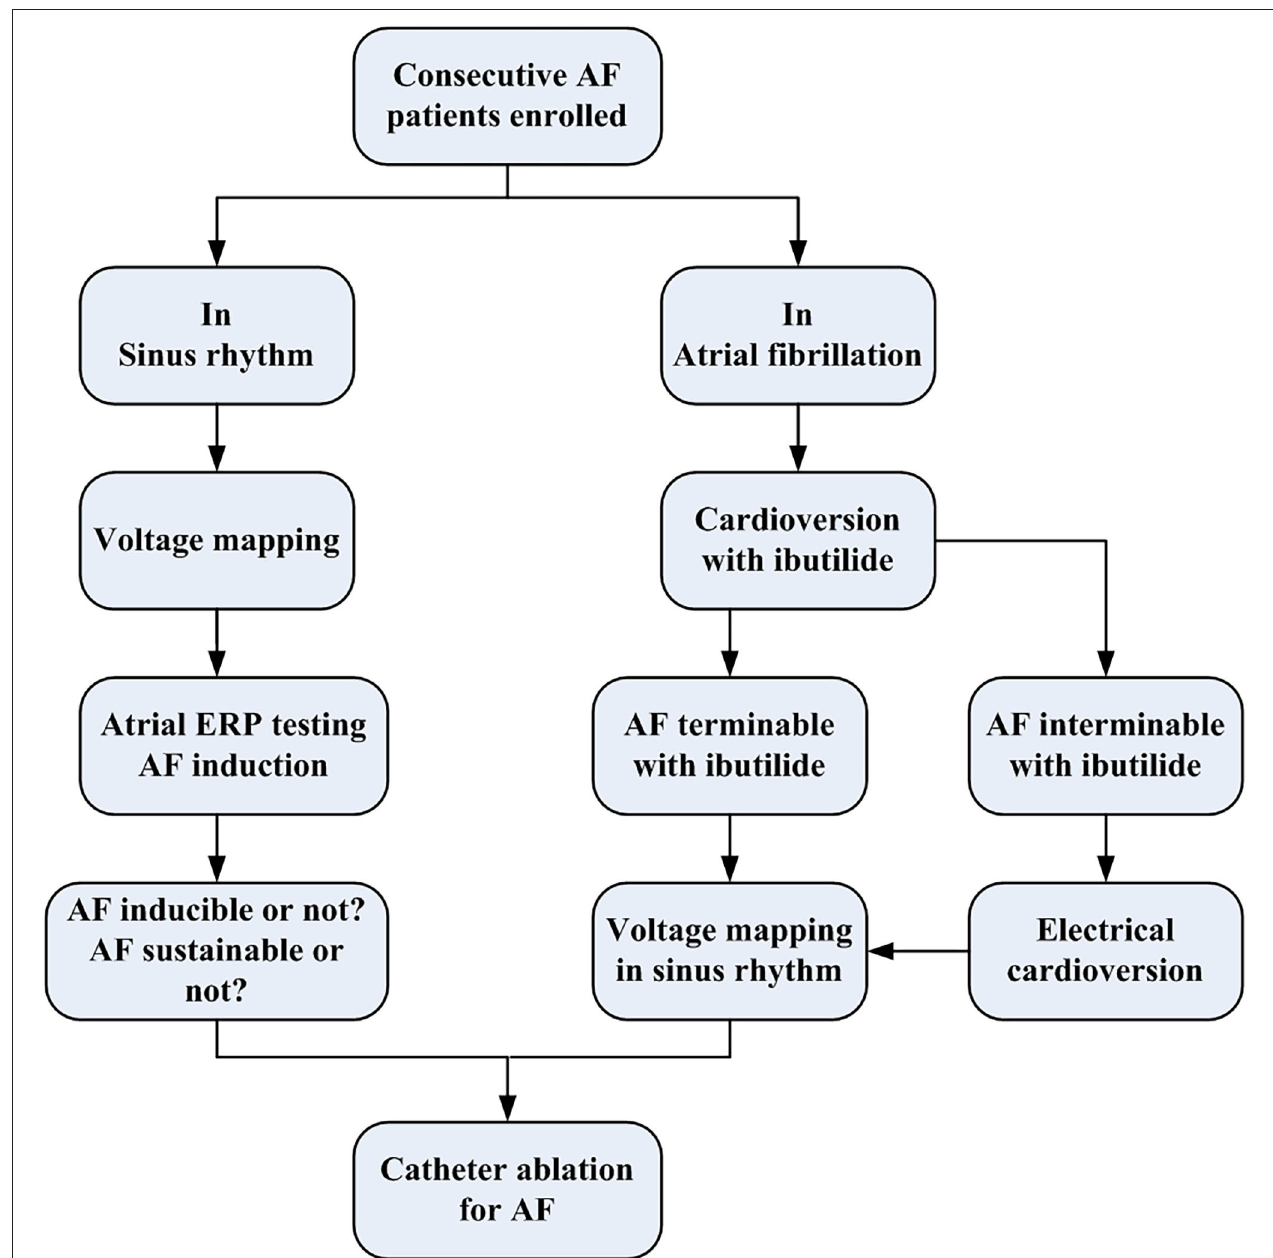
FIGURE 1 | The flowchart of the present study protocol. AF, atrial fibrillation; ERP, effective refractory